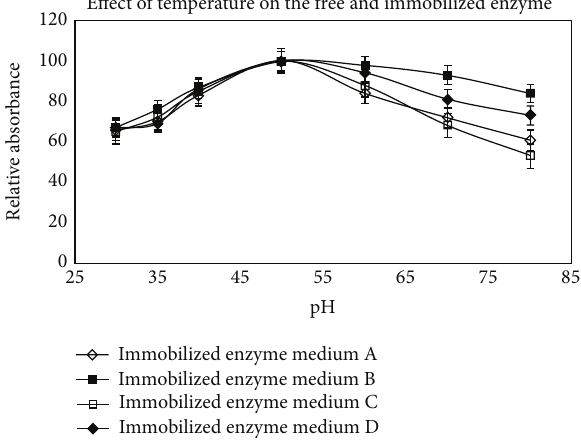
Figure 3: Effect of pH on the free and immobilized urease activity; the relative activities at the optimum pH were taken as 100% for free and immobilized urease, respectively.